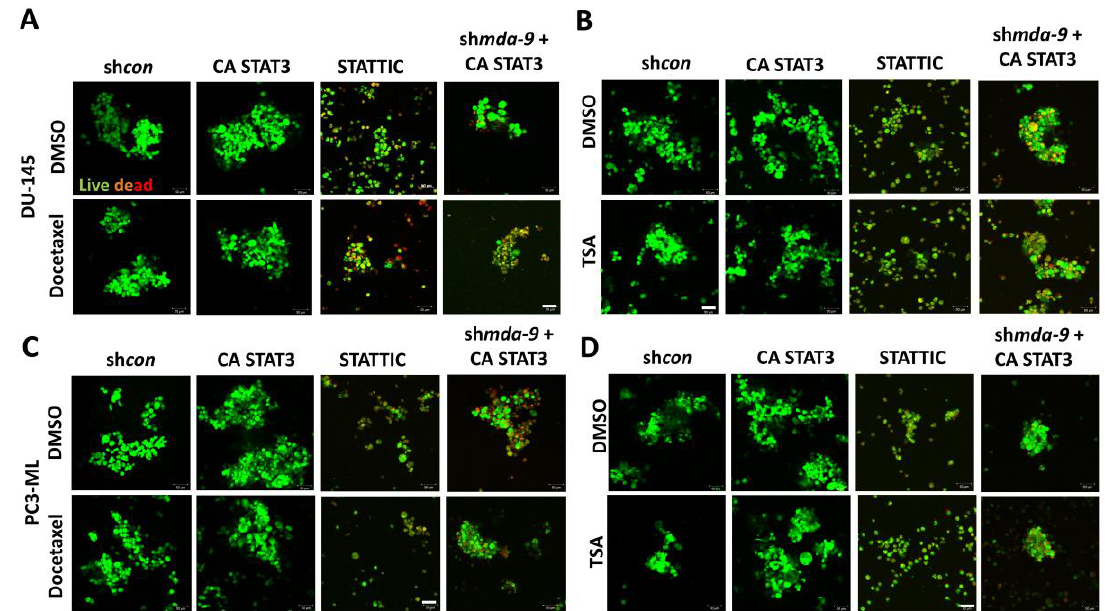
Figure 4. STAT3 activation is downstream of mda-9 and it regulates PCSC chemoresistance. Image analysis of sh con or mda-9 kd (sh mda-9 ) PCSCs overexpressing constitutively active (CA) STAT3 or treated with STAT3 inhibitor STATTIC; ( A ) of DU-145 treated with or without Docetaxel, ( B ) of DU-145 treated with or without TSA ( C ) of PC3-ML treated with or without Docetaxel ( D ) of PC3-ML treated with or without TSA, live cells are green, dead cells are red.